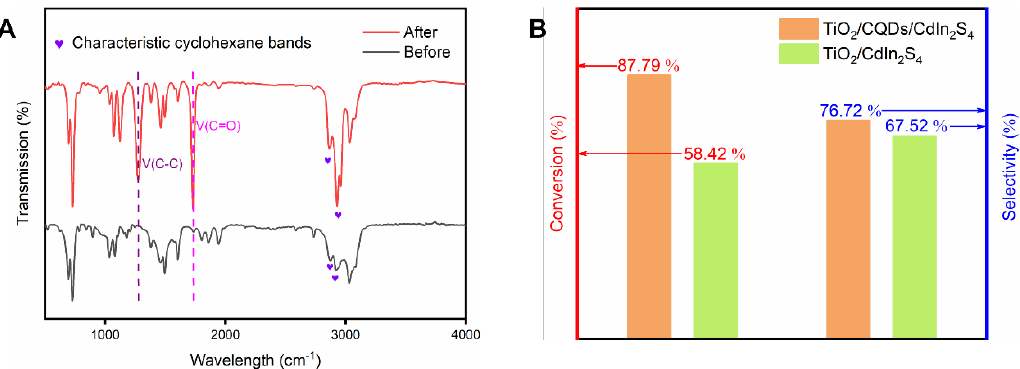
Figure 5. ( A ) FT-TR spectra of PAHs before and after the photocatalytic reactions for 1 h; ( B ) the performance for PAHs photocatalytic degradation over TiO 2 /CQDs/CdIn 2 S 4 and TiO 2 /CdIn 2 S 4 .